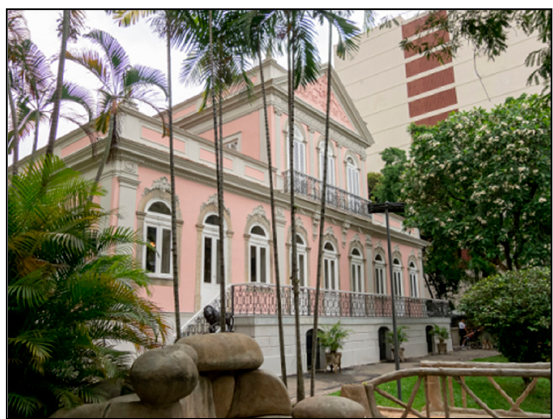
Figure 1. Façade of Rui Barbosa House Museum.